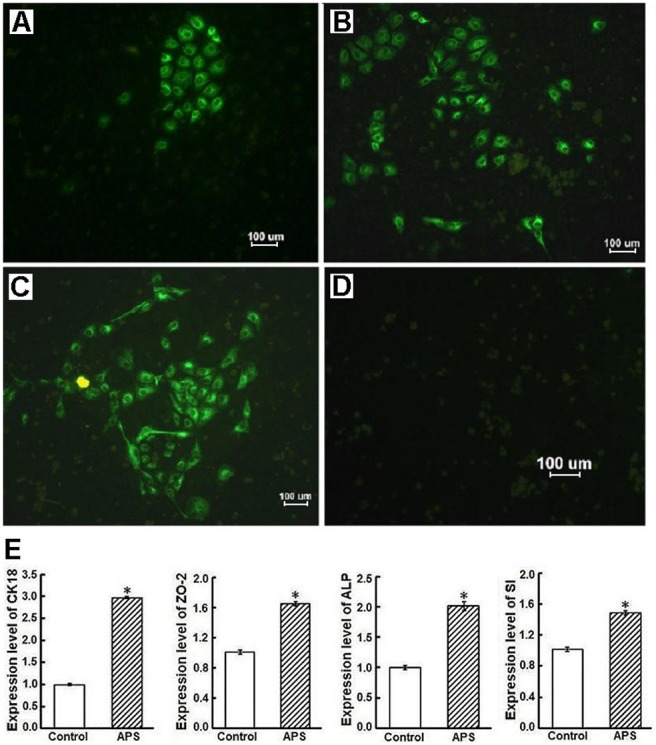
APS-treated IEC-6 cells expressed multiple molecular markers of epithelial differentiation.(A, B, and C) Immunofluorescence assay (IFA) showed that cytokeratin 18 (CK18) was clearly detected in the cytoplasm of APS-treated IEC-6 cells with a green color. The CK18-positive cells increased after 2 to 4 days of incubation with APS. (D) No fluorescence was found in the cytoplasm of untreated cells. (E) Relative expression of the four genes (CK18, ZO-2, ALP, and SI) in APS-treated cells was analyzed by real-time PCR. Expression levels were normalized to the G3PDH gene and are presented as the expression relative to that of the controls (mean ± SD, n = 9). Controls are arbitrarily assigned a value of 1. *P<0.01 compared to control (untreated IEC-6 cells).